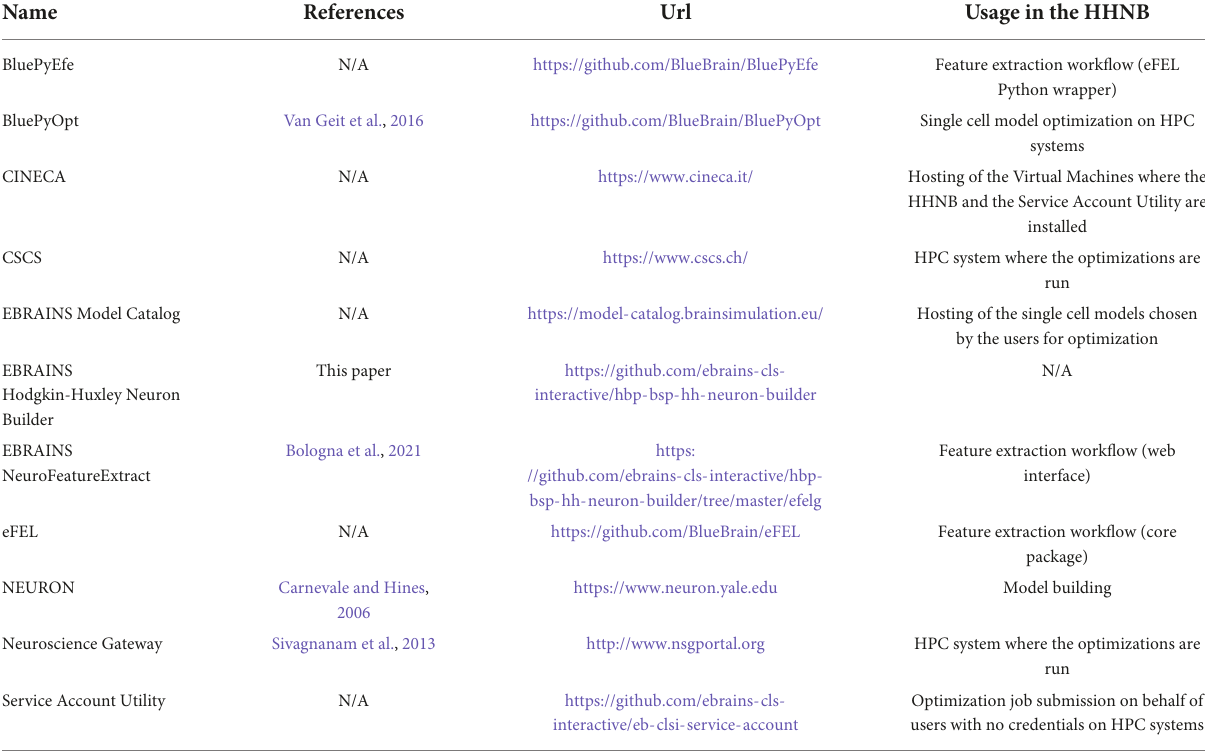
TABLE 1 List of software resources adopted in the paper, with references to publications (if available) and urls. Software